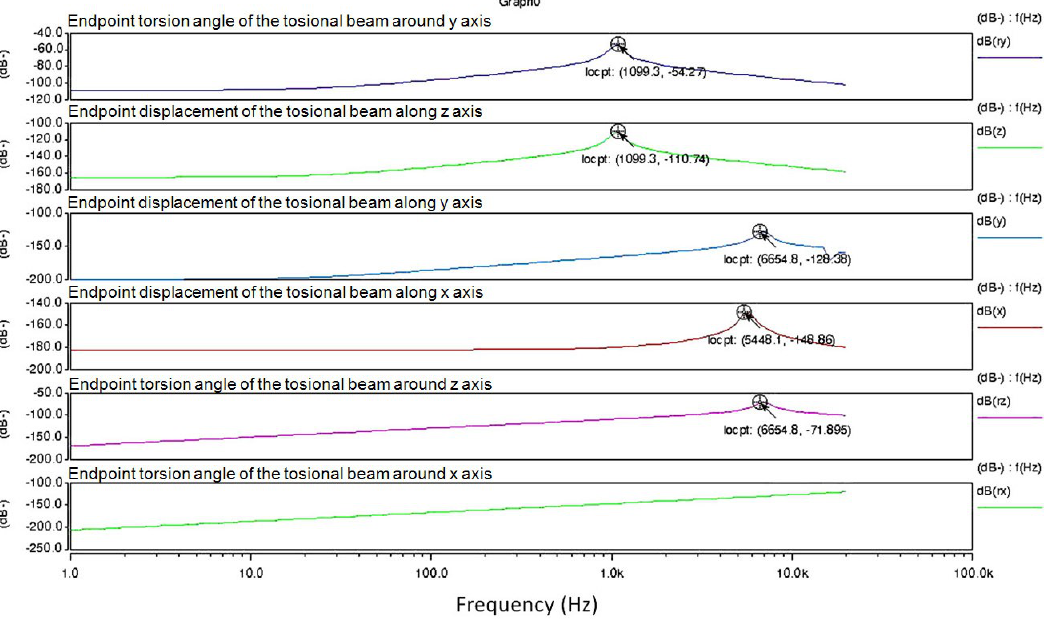
Figure 2. Simulation results for the resonant frequencies of the magnetometer in different directions, indicating the endpoint displacement of the torsional beams along three perpendicular directions and around three axes. Reproduced with permission from [29], published by IEEE, 2013.